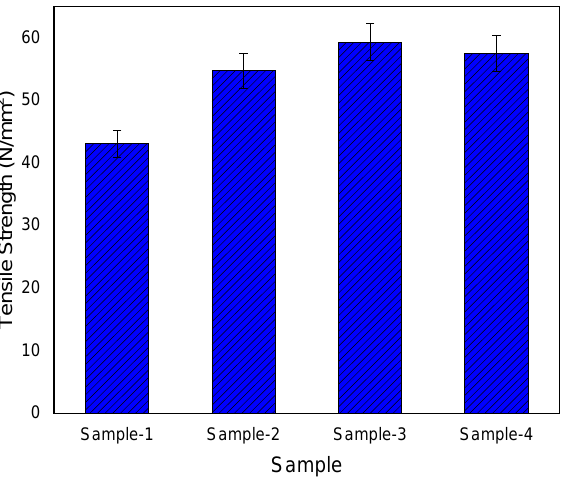
Figure 7. Tensile strength variation for non-functionalized (Sample-1: 0.1 wt.%) and functionalized (Sample-2: 0.1 wt.%; Sample-3: 0.5 wt.%; and Sample-4: 1.0 wt.%) MWCNT/PMMA nanocomposites.